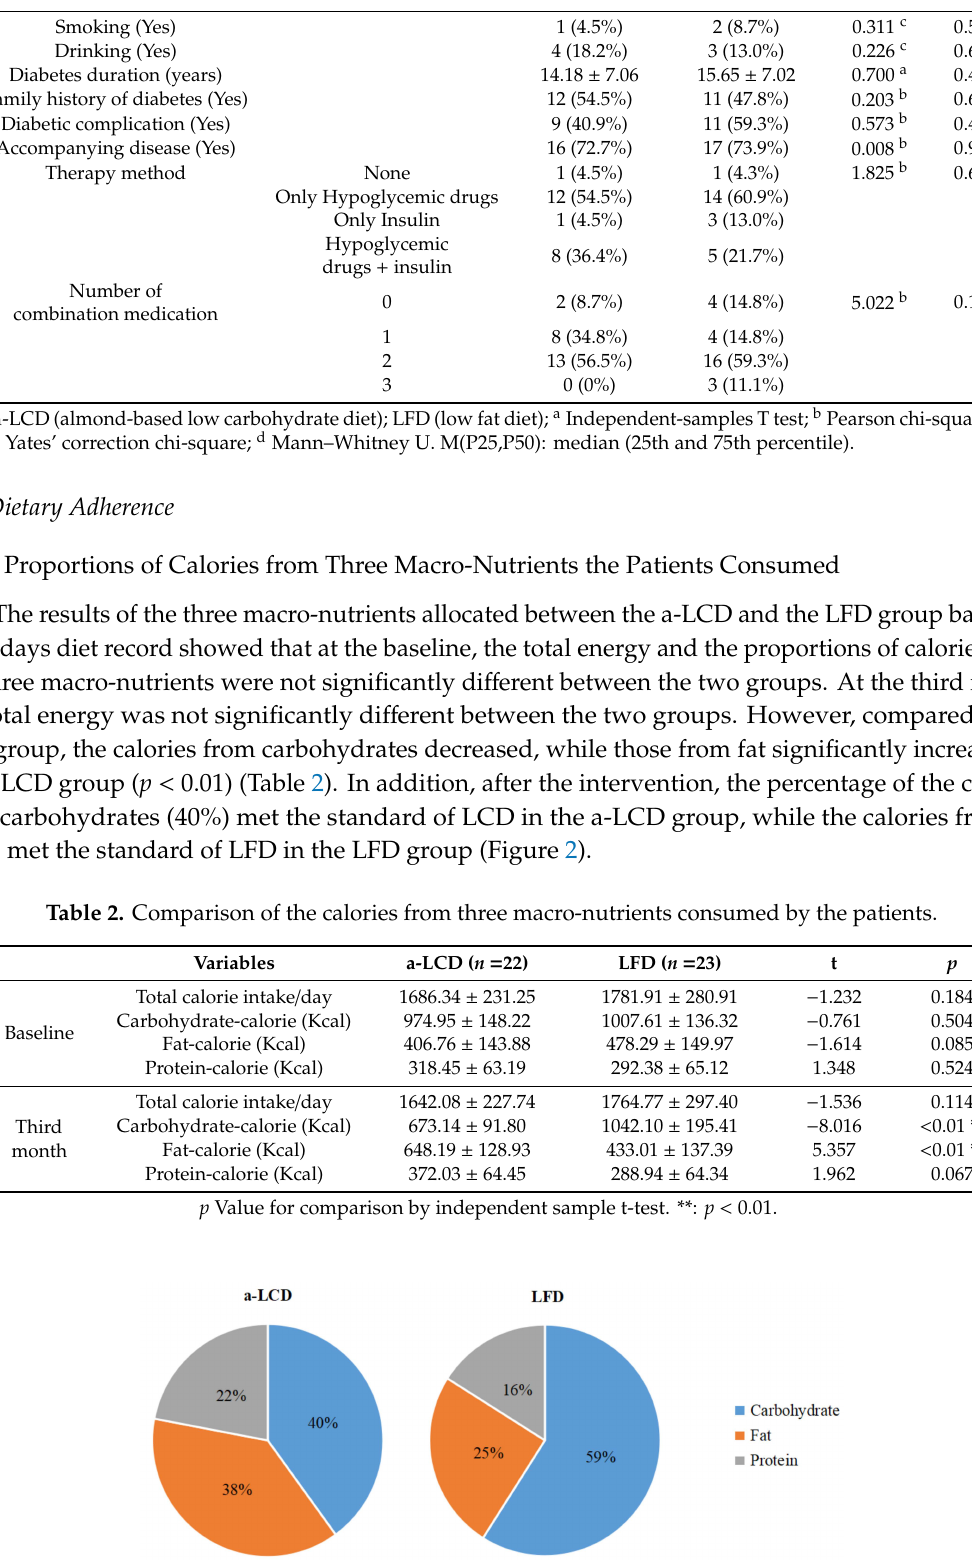
Figure 2. Three macro-nutrient energy supply ratios of two groups after